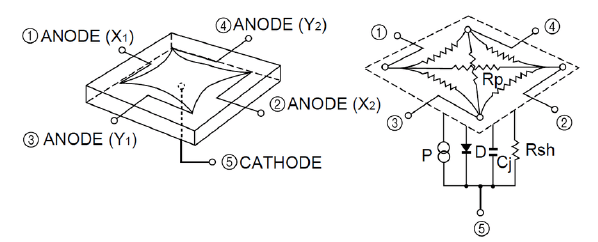
Figure 2. Equivalent circuit of the PSD pin-cushion (image courtesy of Hamamatsu, obtained from the PSD technical